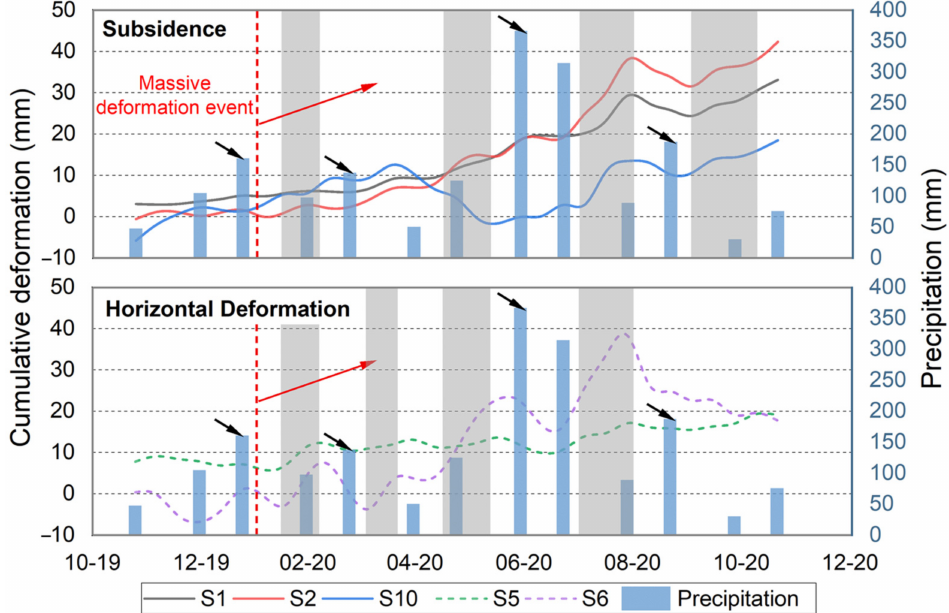
Figure 9. Relationship between cumulative deformation and monthly precipitation. The black arrows indicate 4 periods of peak precipitation, while the four gray columns represent the 4 maximum deformation gradient